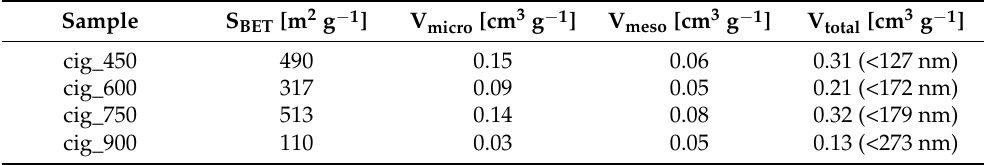
Table 1. BET specific surface area (S BET ), micropores volume (V micro ), mesopore volume (V meso ) and total pore volume (V total ) of the different